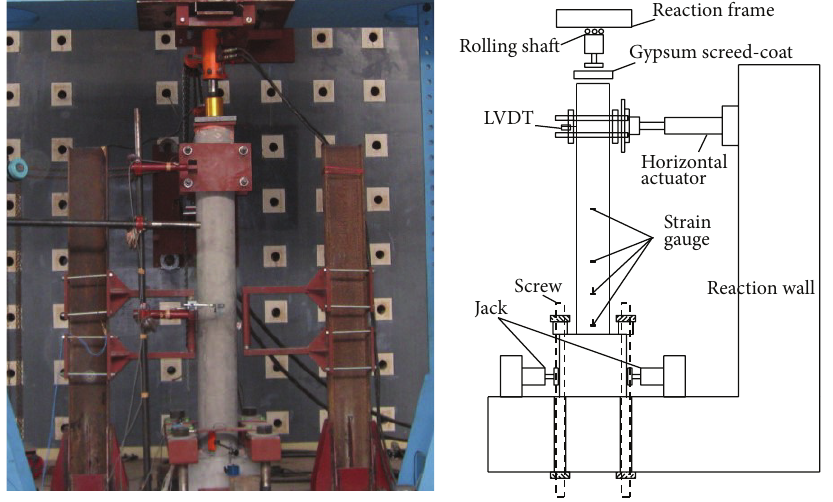
Figure 3: Testing setup.